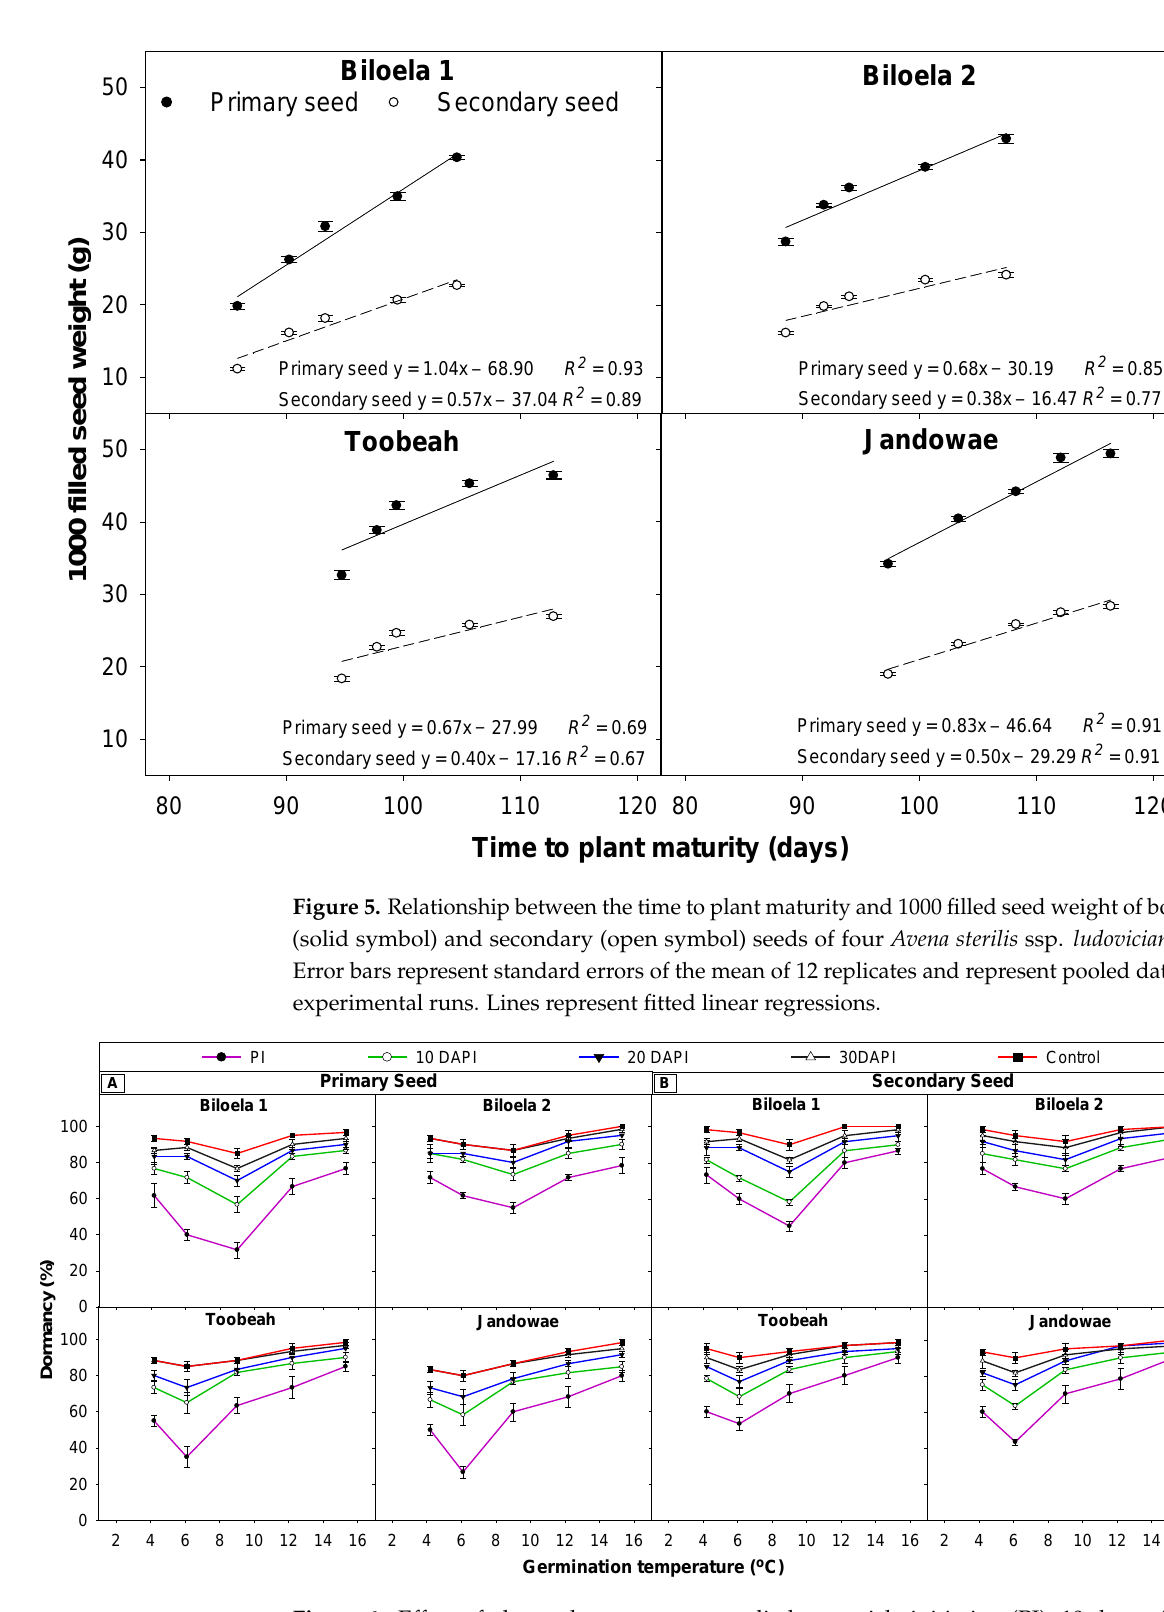
Primary seed Secondary seed Figure 4. Effect of elevated temperature applied at panicle initiation (PI), 10 days after panicle initi-